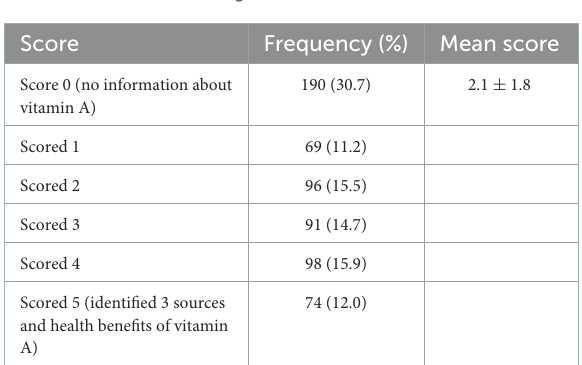
TABLE 3 Vitamin A knowledge